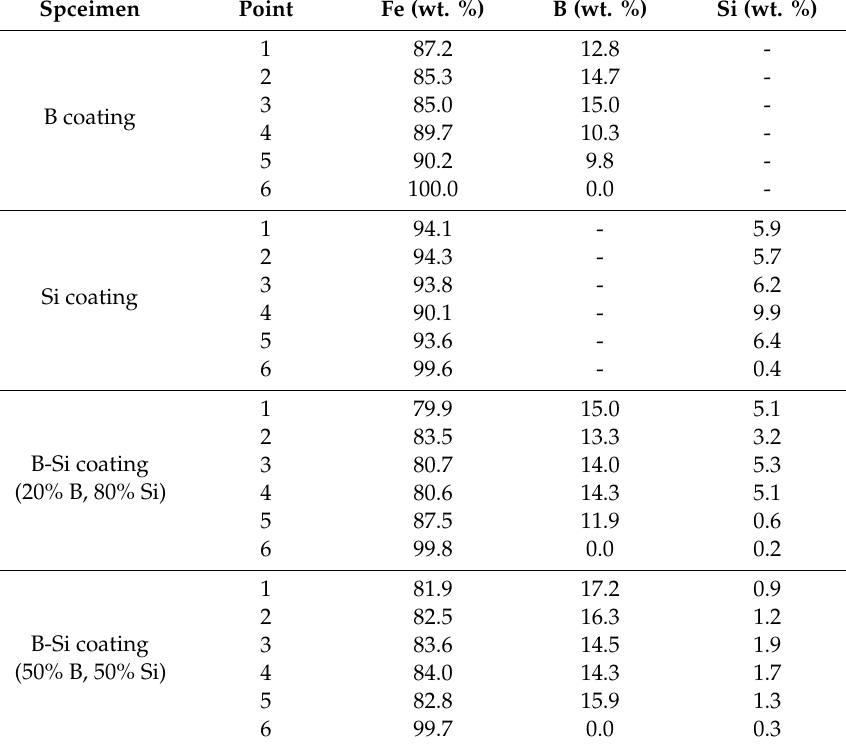
Figure 8. Energy dispersive spectrometry (EDS) point of coatings after laser alloying with: ( a ) boron; ( b ) silicon; ( c ) B-Si containing 20% boron and 80% silicon; ( d ) B-Si containing 50% boron and 50% silicon. Table 2. Chemical composition of B, Si and B-Si coatings. Spceimen